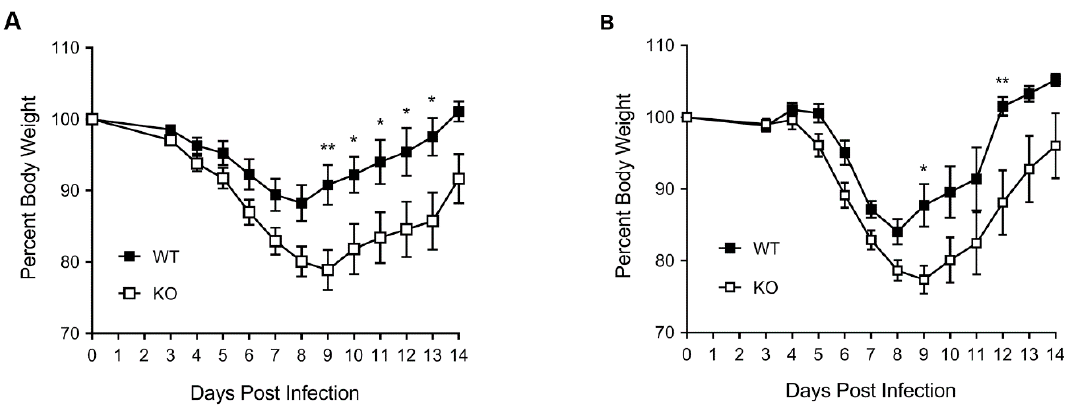
Figure 1. HDAC6 knockout (KO) mice exhibit higher weight loss after influenza A virus (IAV) infection. The wild type (WT) and KO male ( A ) and female ( B ) mice were inoculated intranasally with 150 pfu or 50 pfu of influenza virus A / PR / 8 / 1934 (H1N1) (PR8), respectively. The mice were monitored daily for weight loss from 3 days post-infection until 14 days post-infection. The mouse weight on day 0 (day of inoculation) was considered 100% to determine their weight on subsequent days. The error bars represent the means ± standard errors with 95% confidence interval (male, n = 17 each; female, n = 10 each). The asterisks represent the p value (*, < 0.05; **, < 0.005) calculated by two-way ANOVA incorporating Sidak’s multiple comparisons test.